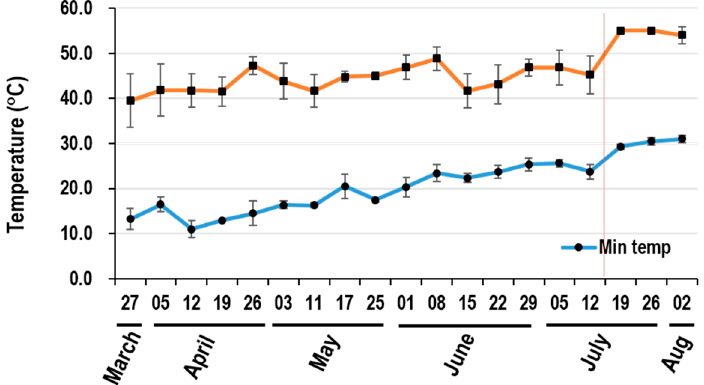
Figure 1. Temperature fluctuations in the glass greenhouse during the cabbage growth period. One-month-old seedlings were grown in a culture room at 22 ◦ C, and then transplanted in pots (20 cm height × 20 cm diameter) on 27 March 2018 and maintained in the greenhouse until August 2, with frequent watering to maintain high humidity. Min temp, weekly average minimum temperature; max temp, weekly average maximum temperature.